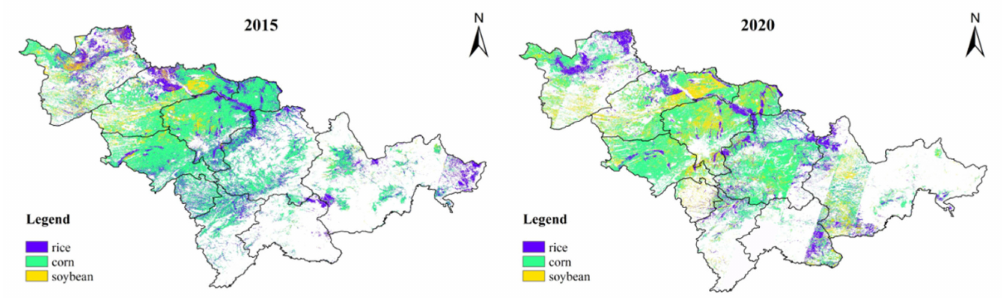
Figure 7. Distribution map of the main crops in the study